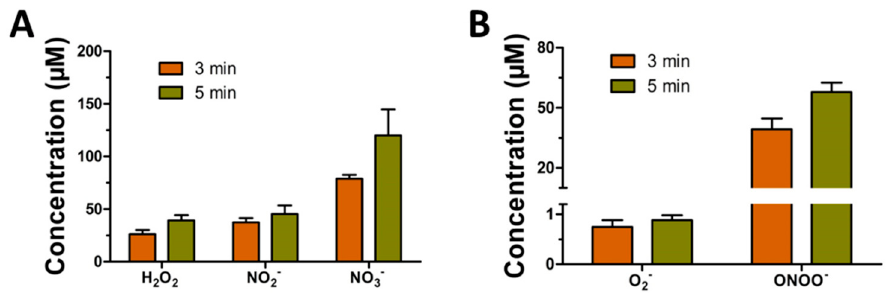
Figure 2. Detection of reactive oxygen species (ROS) and reactive nitrogen species (RNS) in plasma- activated water (PAW). ( A ) The concentration of long-lived particles H 2 O 2 , NO 2 − and NO 3 − in the solution after plasma treatment for 3 and 5 min. ( B ) The concentration of short-lived particles O 2 − and ONOO − in the solution after plasma treatment for 3 and 5 min.